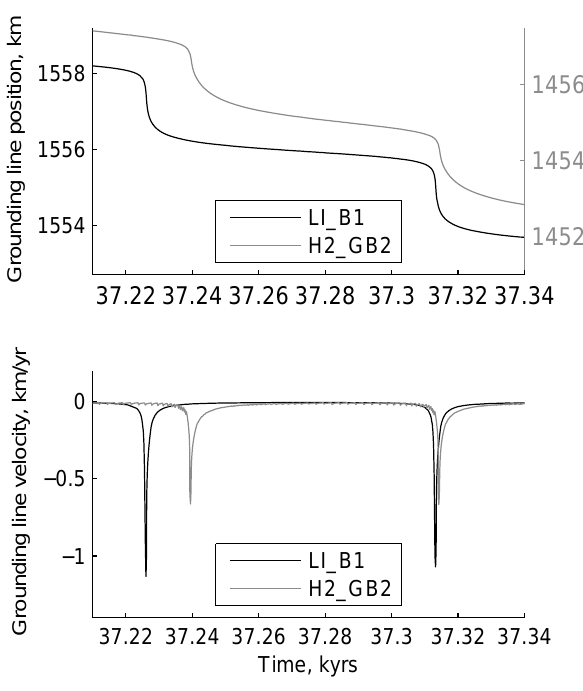
Fig. 5. Time evolution of grounding line position for all GLPs at a resolution of 2.4km. The final grounding line positions from the advance simulations have been extended with dashed lines to facilitate comparison against the retreat simulations. The retreat simulations for the simplest (LI B1) and “best” (H2 GB2) GLPs are shown with dashed lines.